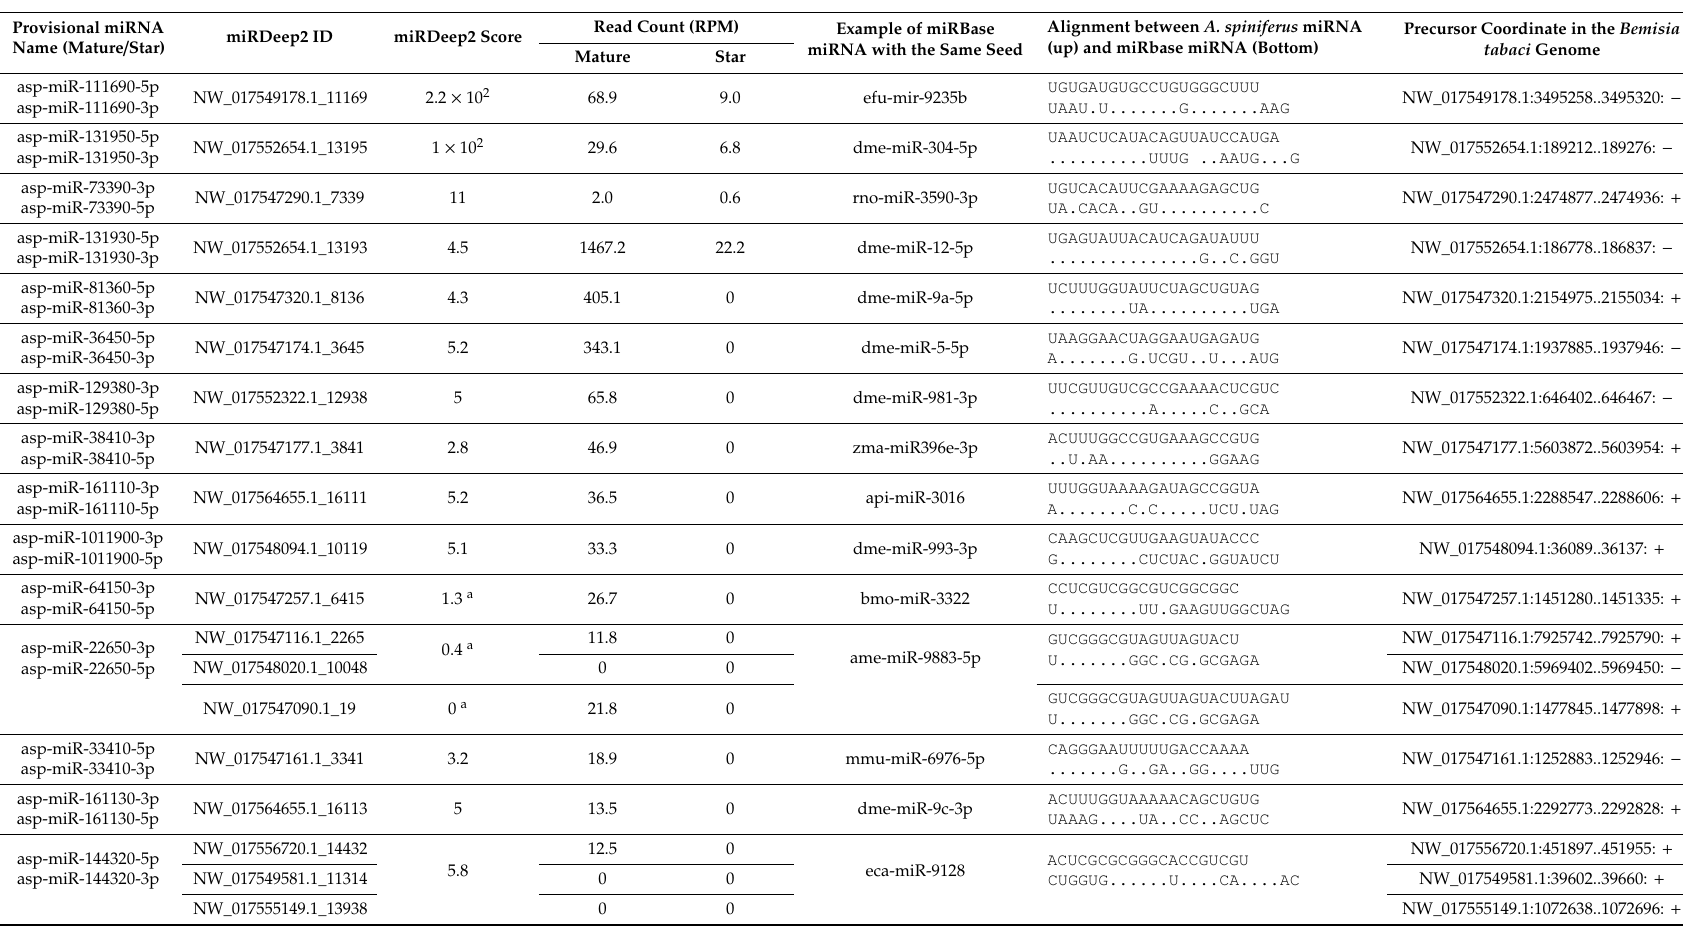
Table 2. Novel miRNAs (more than two mismatches shared with miRBase sequences) detected by miRDeep2 tool using Aleurocanthus spiniferus small RNA reads, Bemisia tabaci genome, and miRBase 22